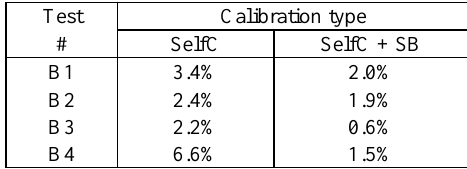
Table 2 . Relative errors of the 3D models obtained in the 4 image sets made under trees